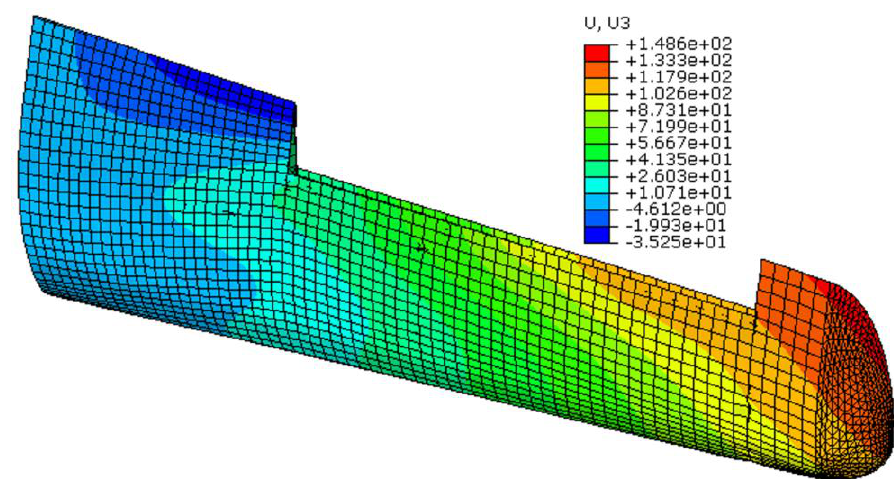
Figure 9. The structure of the airfoil.